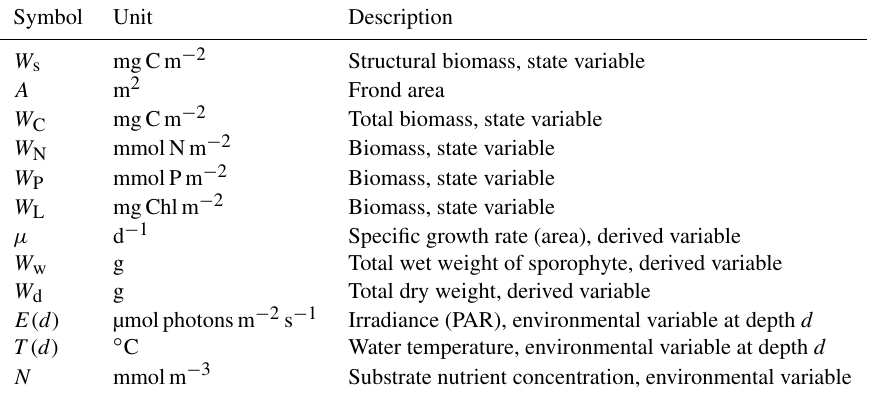
Table 1. Variables of the macroalgae